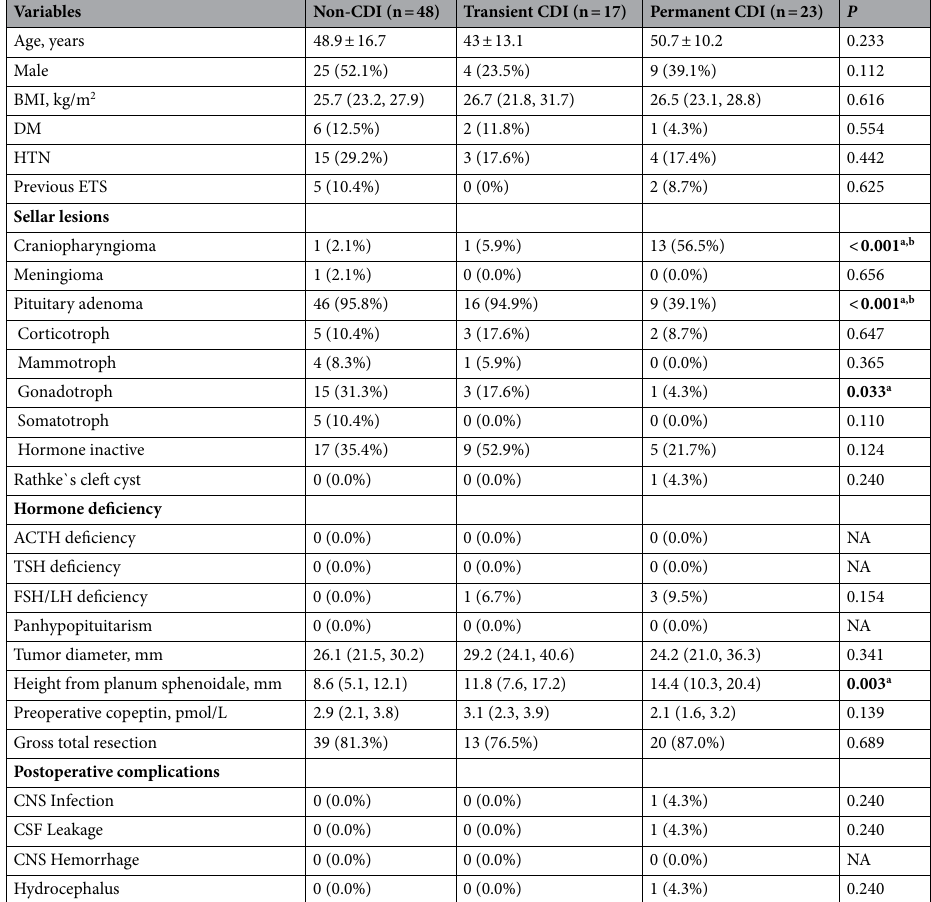
Table 1. Baseline characteristics of patients according to the presence of postoperative central diabetes insipidus. Data were represented as mean ± SD, number (proportion) or median (IQR). In bold P -values were calculated by one-way analysis of variance among the three groups. a , P < 0.05 between non-CDI and permanent CDI; b , P < 0.05 between transient CDI and permanent CDI; c , P < 0.05 between non-CDI and transient CDI. CDI, Central diabetes insipidus; BMI, Body mass index; Ex, ex-smoker or ex-drinker, respectively; DM, Diabetes mellitus; HTN, Hypertension; ETS, Endoscopic transsphenoidal surgery; NA, Not applicable; TSH, Thyroid stimulating hormone; ACTH, Adrenocorticotropic hormone; FSH, Follicular stimulating hormone; LH, Luteinizing hormone; Op., Operative; CNS, Central nervous system; CSF, Cerebrospinal